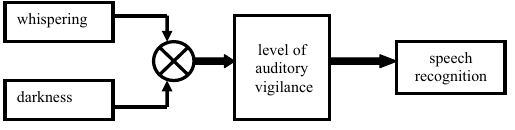
Fig. 2 – Schema illustrating the concept of a vigilance experi- ment. It describes the prediction that the variables listed on the left side (here: whispering and darkness) raise the level of audi- tory vigilance, and that this effect would influence the variable on the right side (here: speech